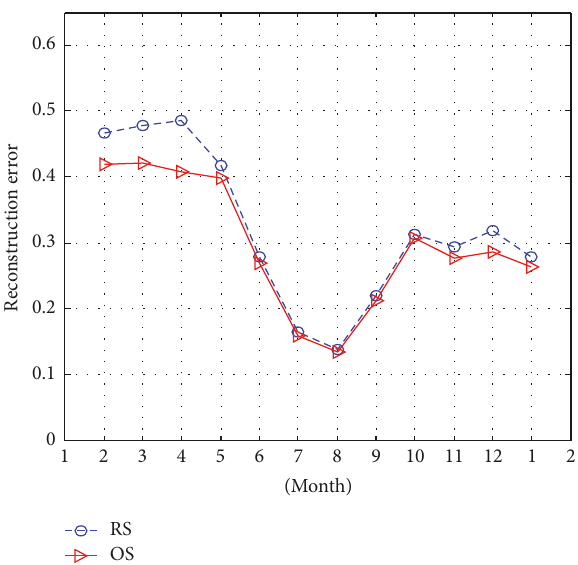
Figure 7: Reconstruction error in the sampled field from February 2008 to January